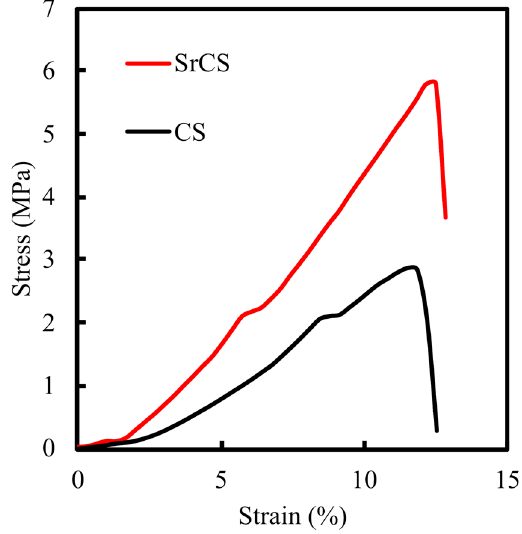
Figure 3. Surface SEM images of the CS and SrCS scaffolds and evolution of different ions by energy